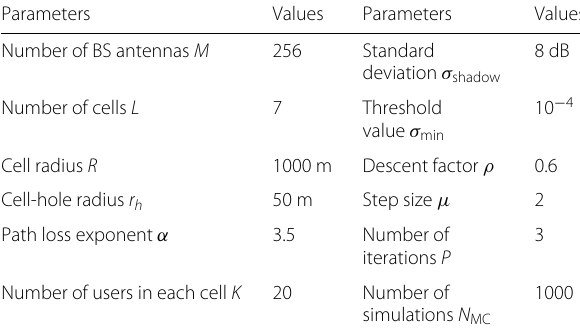
Table 1 System and algorithm parameter